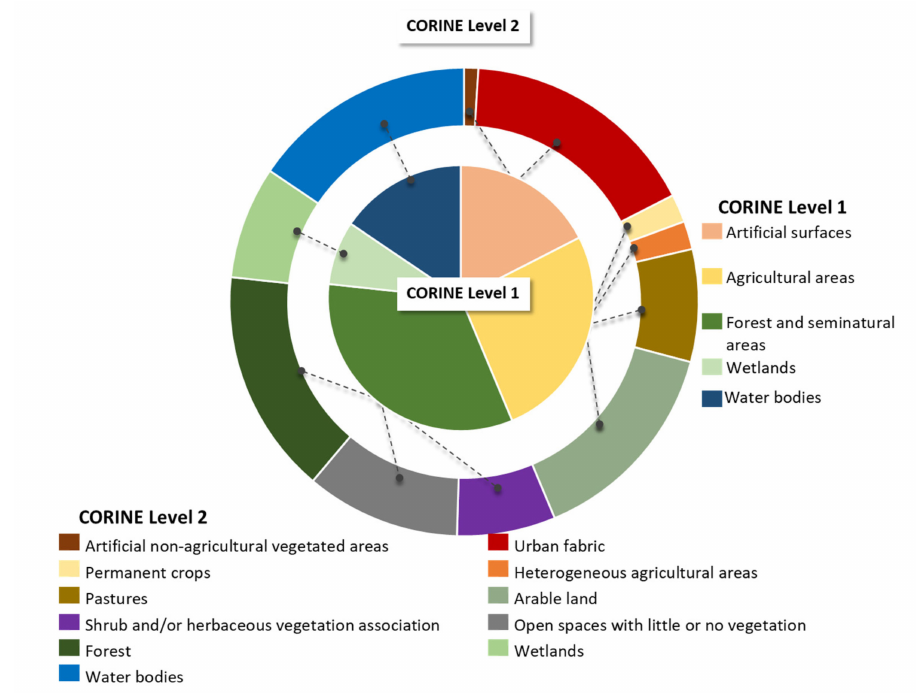
Figure 3. LULC identified in this research according to CORINE land cover classification Level 1 and Level 2.